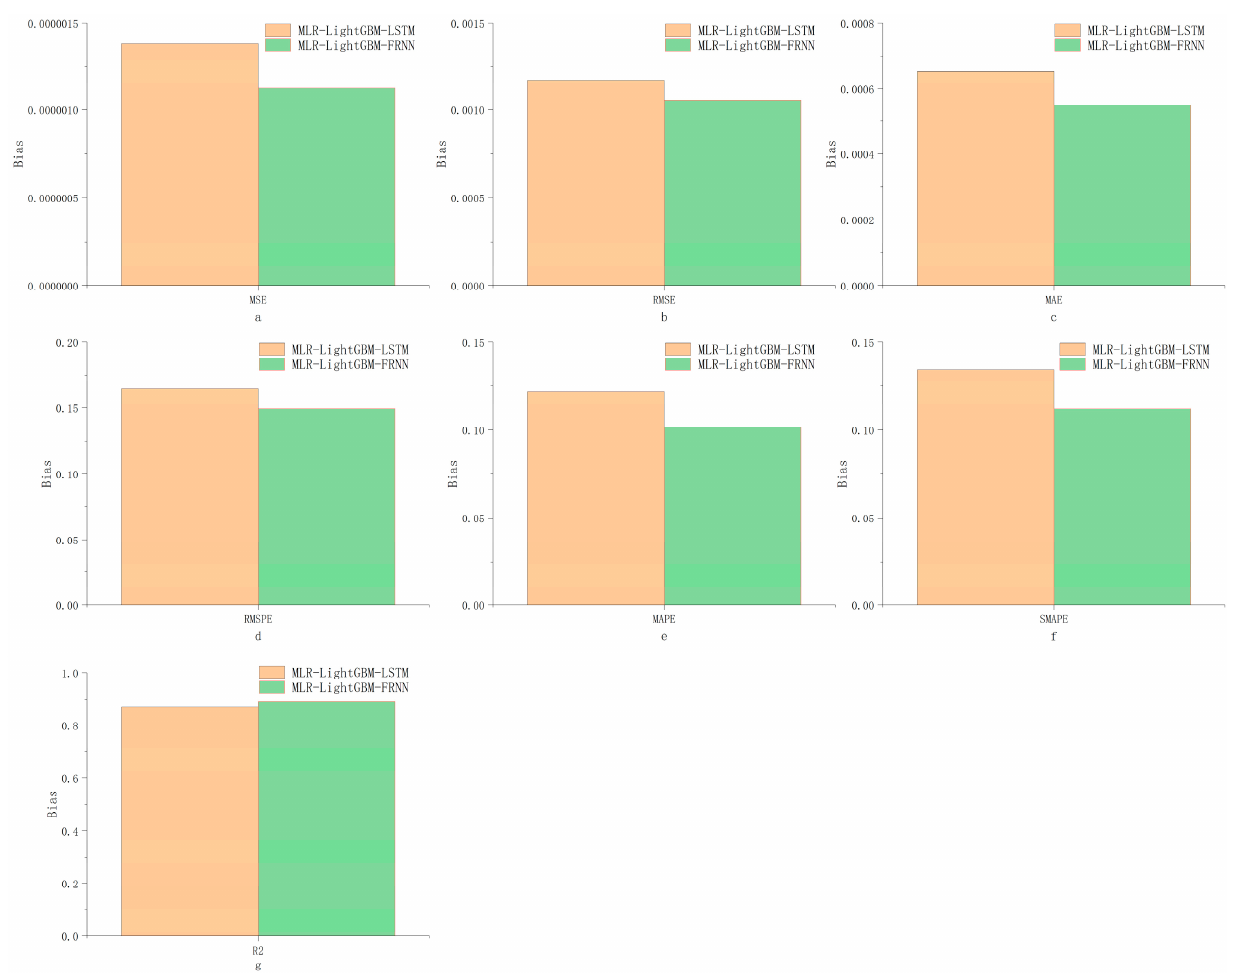
Figure 24. Bias comparison ( a – g are seven different evaluation metrics). Table 7. Error comparison of models.